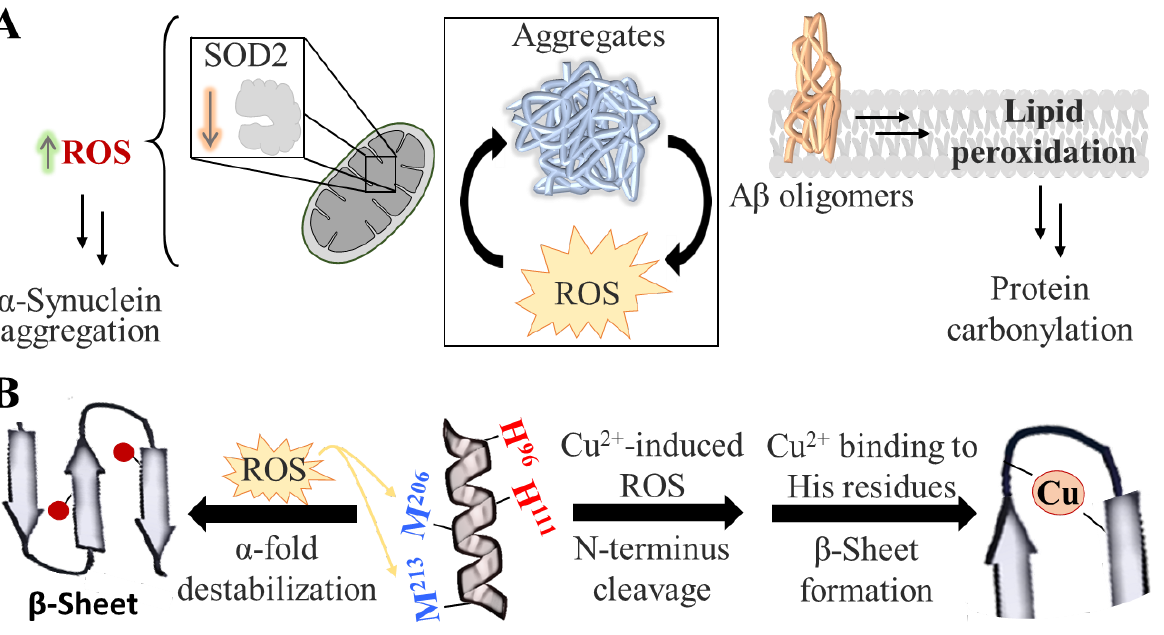
Figure 2. Interplay between protein aggregates and oxidative damage. ( A ) Increased protein aggregation in several neurodegenerative diseases is associated with increased ROS levels. This relationship is bidirectional; excessive ROS production is found to induce protein aggregation and vice versa. Two examples of this vicious cycle are shown: (1) a decrease in the mitochondrial levels of Superoxide dismutase 2 (SOD2) gives rise to elevated ROS, which in turn promotes Α -synuclein aggregation (right panel) and (2) the accumulation of Αβ oligomers induces lipid peroxidation, an oxidative damage that further results in protein carbonylation (left panel). ( B ) Proposed mechanisms of ROS-induced aggregation of prion protein. At physiological conditions, part of the prion protein exists in the α -fold form (depicted as a helix in the middle). However, in disease, its scrapie isoform forms β - sheets, which eventually drive fibrillation. The transition from α - fold to β -sheet is proposed to be mediated by ROS, with two different mechanisms: (1) by methionine oxidation (depicted as red ci rcles), which destabilizes the α -fold form (left side) or (2) by ROS-mediated cleavage — induced by copper — of the protective N-terminus of prion, and subsequently, β -sheet